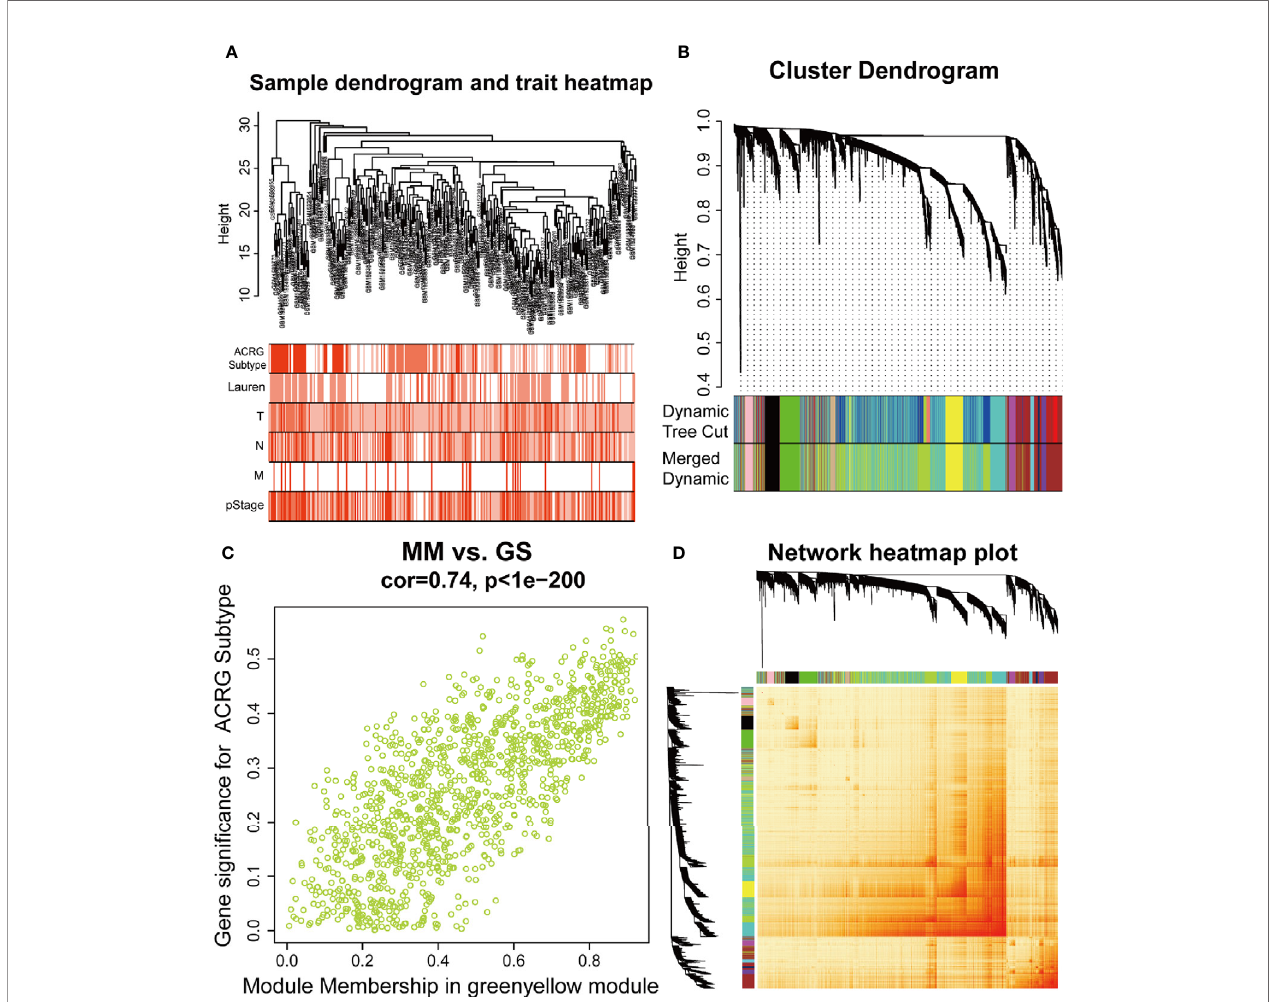
FIGURE 2 | Identi fi cation of the weighted gene co-expression network analysis (WGCNA) hub module and relationship with clinical traits. (A) Sample cluster dendrogram and heatmap of corresponding clinical traits. Each branch represents a sample of gastric cancer (GC). (B) Dendrogram of genes clustered into 12 colored modules based on a dissimilarity measure (1-TOM). Each branch represents a gene. (C) The correlation between green-yellow module and Asian Cancer Research Group (ACRG) subtype. MM, module membership; GS, gene signi fi cance. (D) The cluster dendrogram and heatmap of network based on the topological overlap